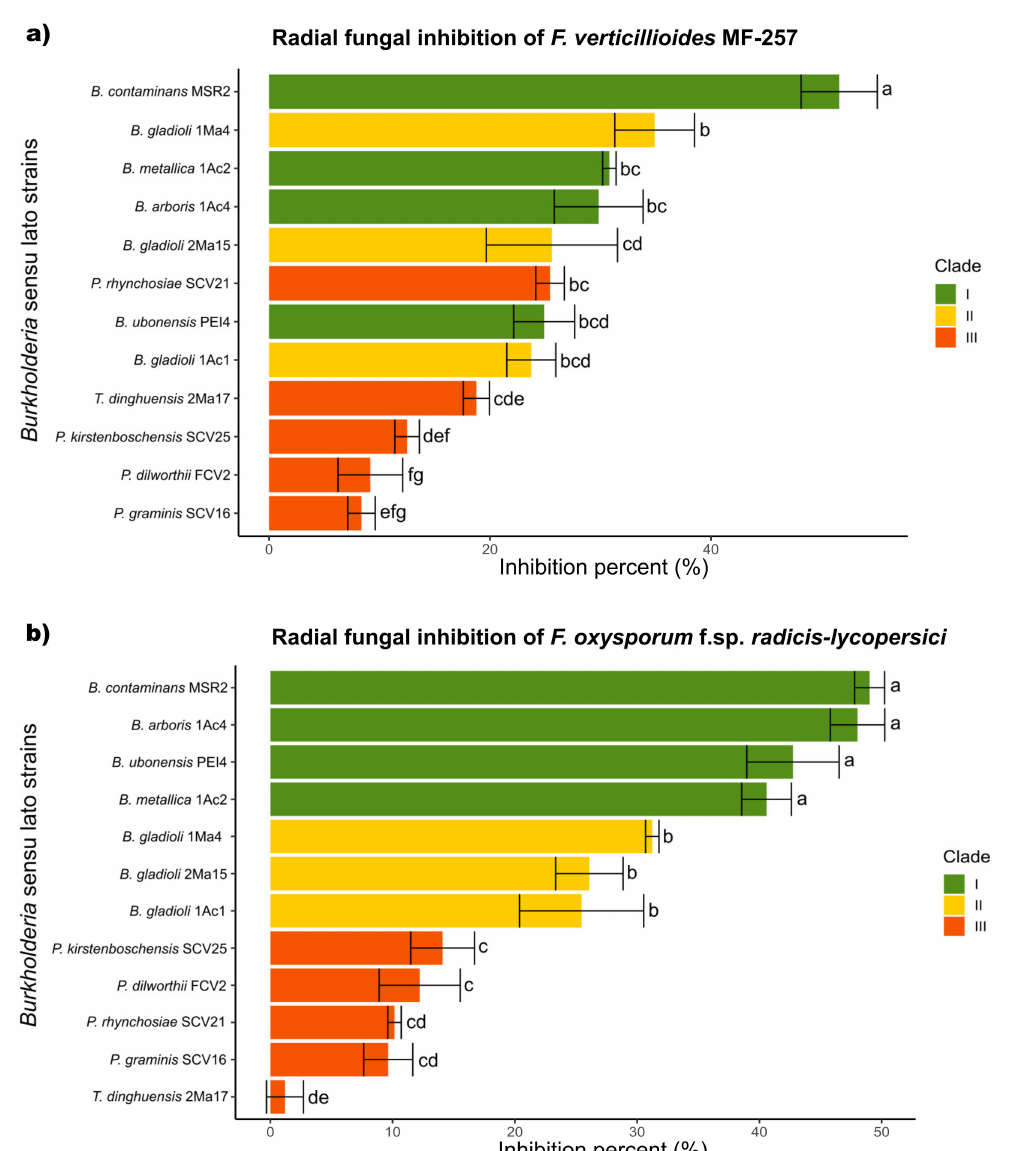
Figure 3. Antifungal activity of Burkholderia sensu lato strains against Fusarium pathogens. The colored bars represent the percentage of inhibition produced against ( a ) F. verticillioides MF-257 and ( b ) F. oxysporum f. sp. radicis - lycopersici by Burkholderia sensu lato bacteria isolated from the rhizosphere of maize plants. The bar colors represent their different phylogenetic classifications: green = Clade I; yellow = Clade II; and orange-red = Clade III. Data are the mean values ( ± std. error) representative of experiments that were performed with five ( F. verticillioides ) and three ( F. oxysporum ) biological replicates per bacterial isolate. Different letters alongside the inhibition percent values represent statistically significant differences (one-way ANOVA, Tukey test, p <